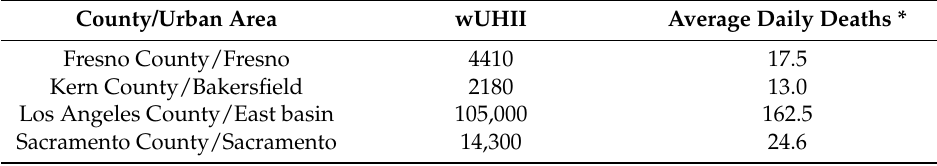
Table 3. Weighted UHII (wUHII) and actual mortality in four counties during July